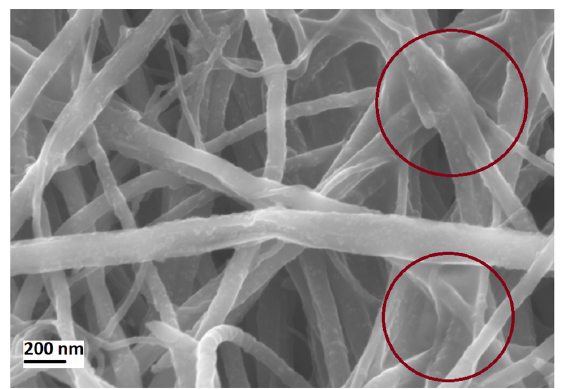
Figure 11. SEM image of f ‐ MWCNTs/Cu nanocomposite obtained by the chemical